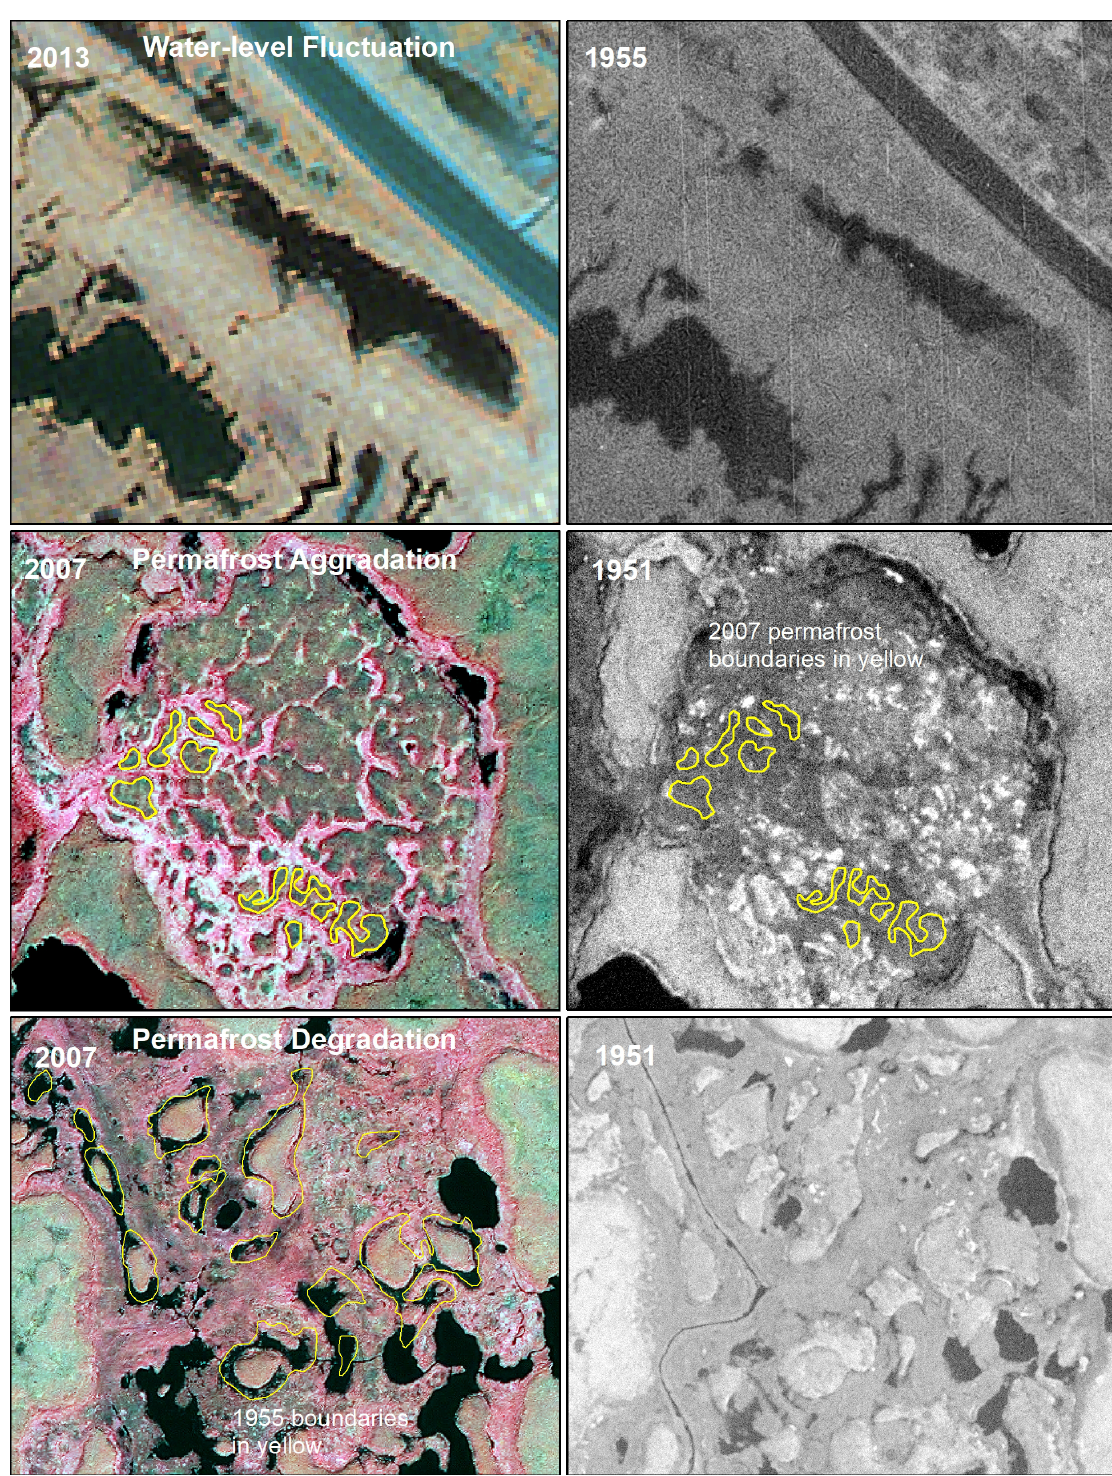
Figure 4. Examples of landscape changes due to water-level fluctuation (or lack of), permafrost aggradation and permafrost degradation evident on imagery from 1951–1955, 1980, 2007 and 2013 along the central coast of the Yukon-Kuskokwim Delta. 2013 imagery © Digital Globe, NextView